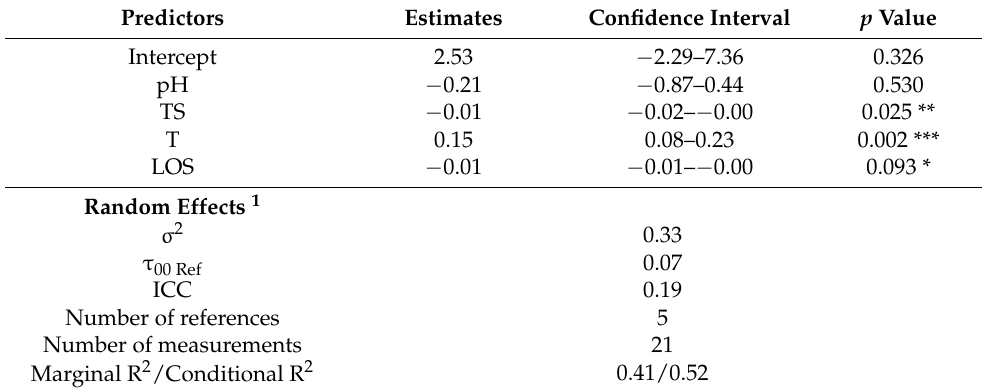
Table 6. Parameter estimates of linear mixed effects model for CH 4 –C emissions from slurry